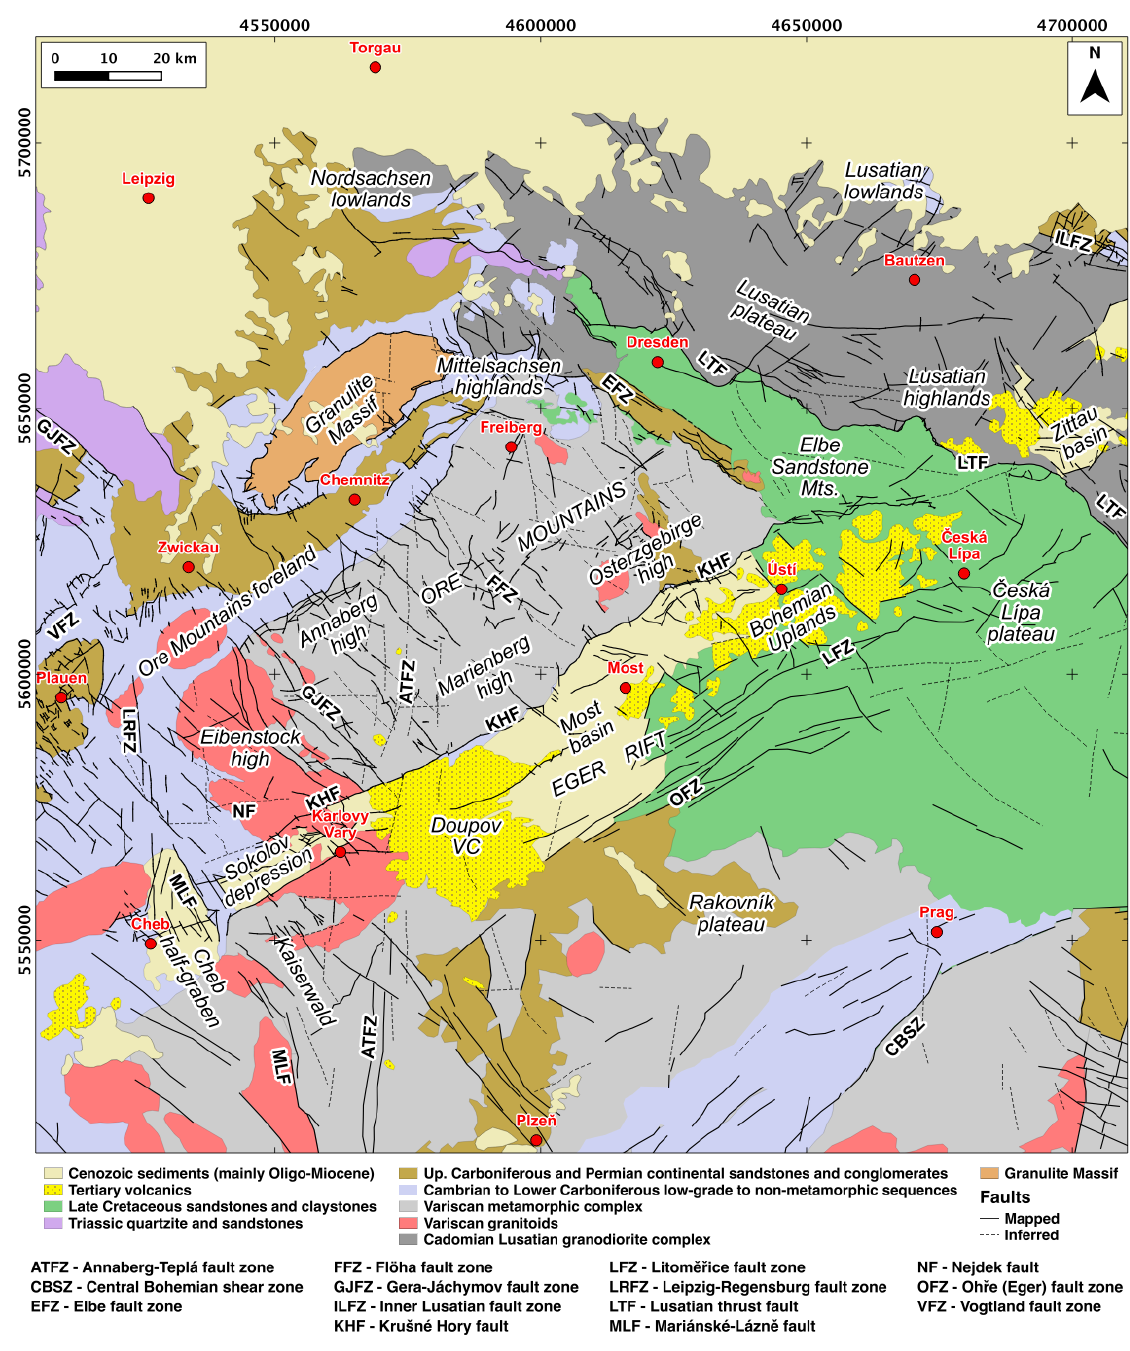
Figure 2. Simplified geology and structures of the Eger Rift and Ore Mountains regions, compiled from the geological map at 1:400,000 for Saxony [55] and from the geological map at 1:500,000 for the Czech Republic [56]. This map and the following maps are projected using the Gauss-Krüger Zone 4 coordinate system (EPSG—European Petroleum Survey Group—code: